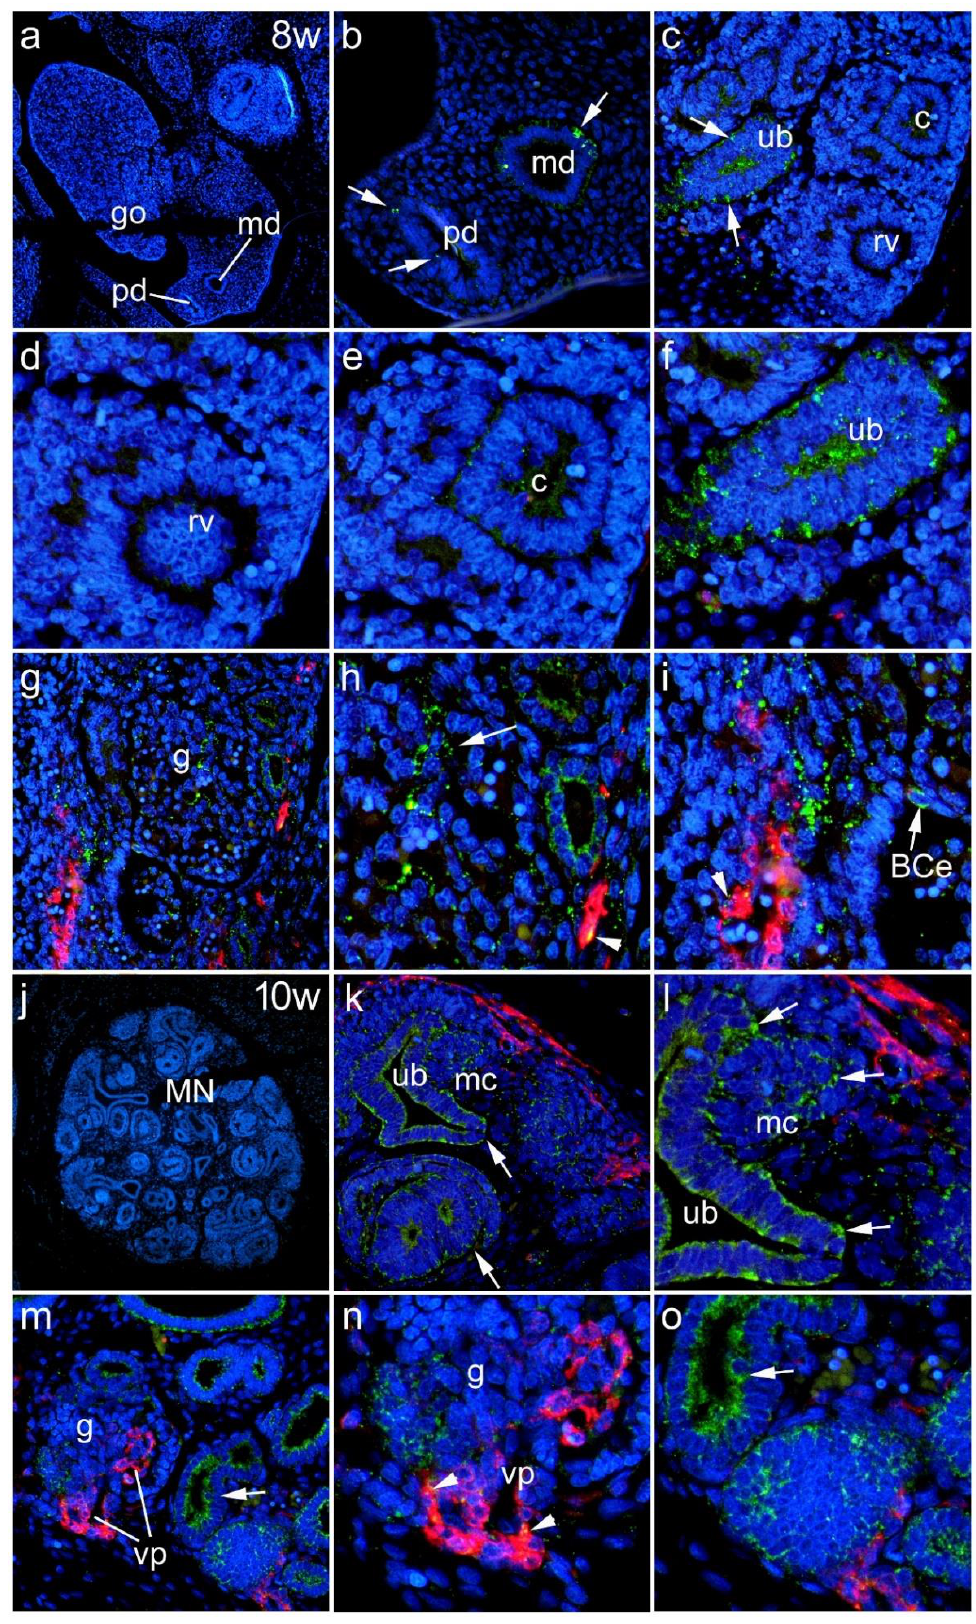
Figure 2. Expression of Panx1 during the 8th to 10th week of human kidney development . In the 8th developmental week, paramesonephric duct (pd) and mesonephric duct (md) were seen on the lateral side of the developing gonad (go) ( a ). Expression of Panx1 was present in both the